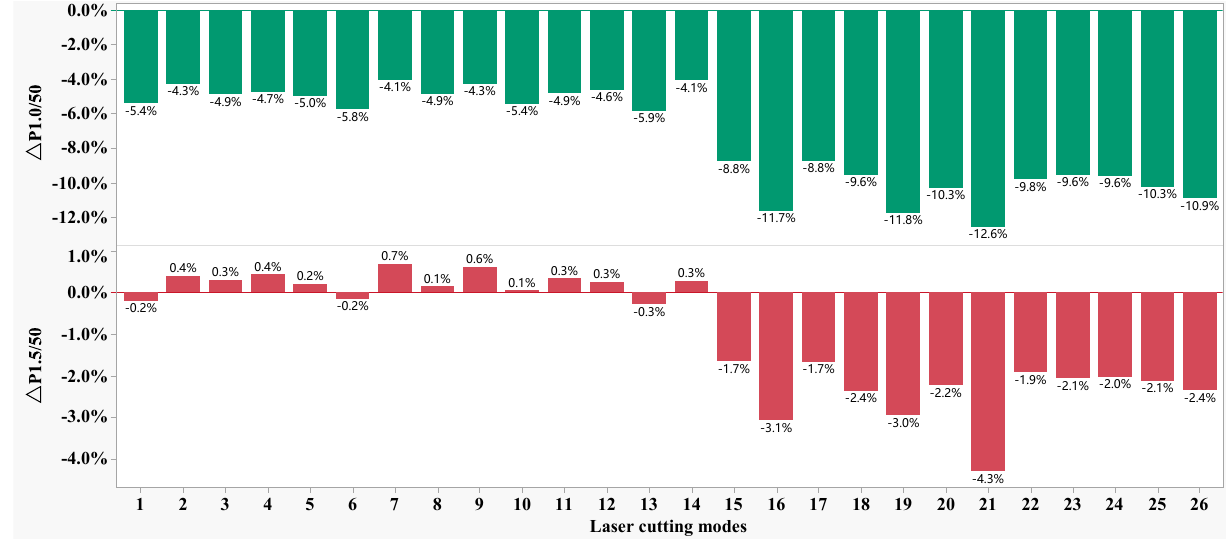
Figure 3. Δ P s distribution under the various laser cutting parameters. Figure 3. ∆ P s distribution under the various laser cutting parameters.